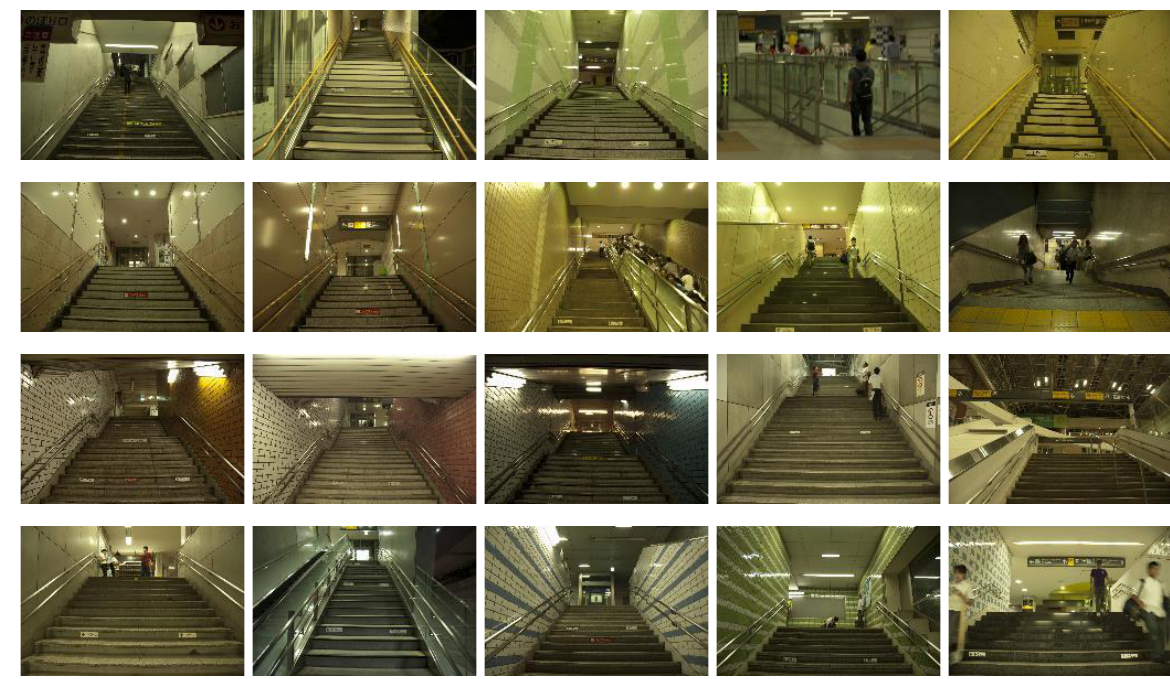
Figure 1. Front view of the stairs